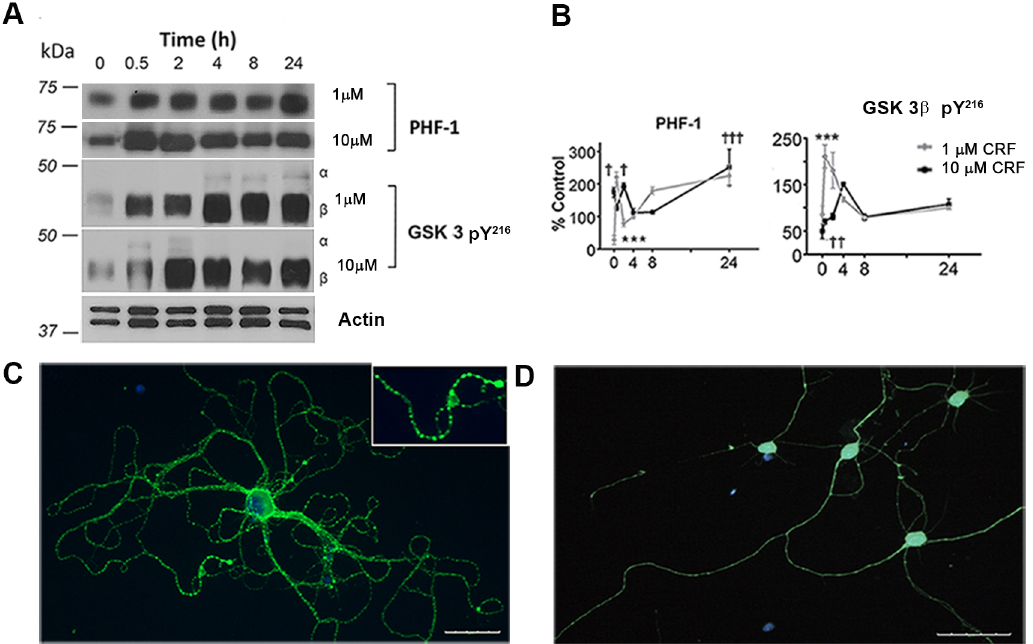
Fig 1. Stress-induced tau-P and kinase activation. (A) Western blot of PHF-1 and GSK-3 pY 216 in cultured mouse hippocampal cells exposed to low or high concentrations of stress hormone CRF (1 μ M or 10 μ M) over a period of 0, 0.5, 2, 4, 8, or 24 hours with β -actin as a loading control. (B) Quantitative analysis of western blots (n = 3). Treatments differ significantly from controls; PHF-1 † (p = 0.01), ††† (p < 0.001), *** (p < 0.001); Active GSK 3 β pY 216 †† (p = 0.006), ††† (p < 0.001), *** (p < 0.001). (C) Immunostaining with PHF-1 (green) of neuronal treated with 10 μ M CRF and (D) vehicle control cell nuclei with DAPI staining